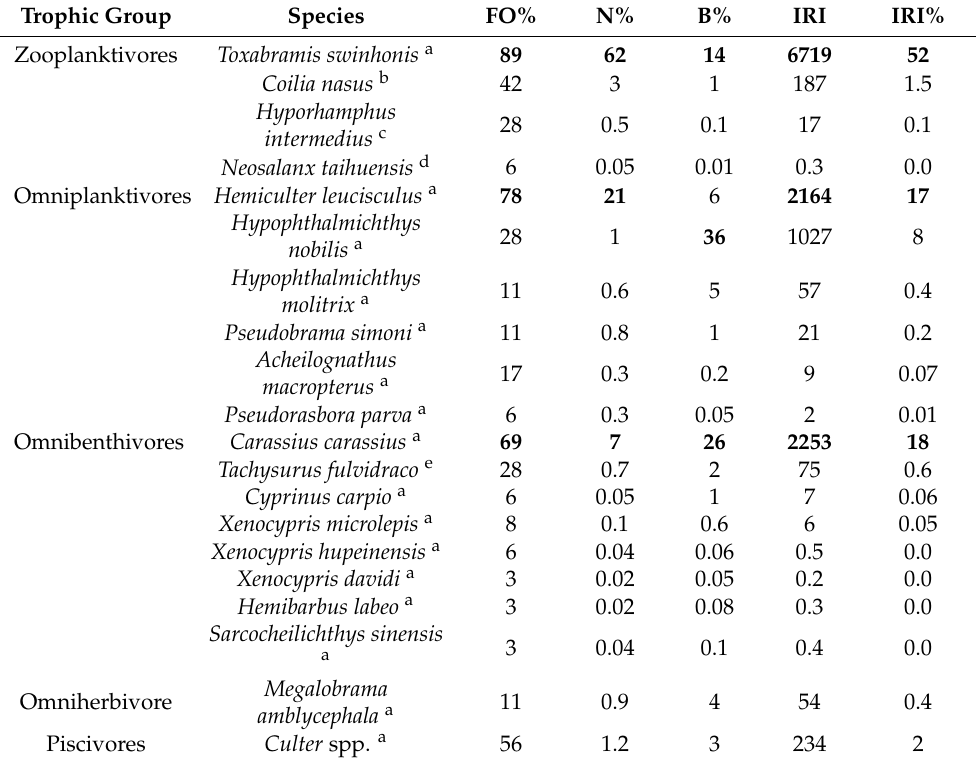
Table 3. Frequency occurrence (FO%), relative contribution by number (N%) and biomass (B%), and index of relative importance (IRI) of the fish sampled. Note: The highest value for each trophic group is given in bold when there are more than one species in the trophic group. Trophic